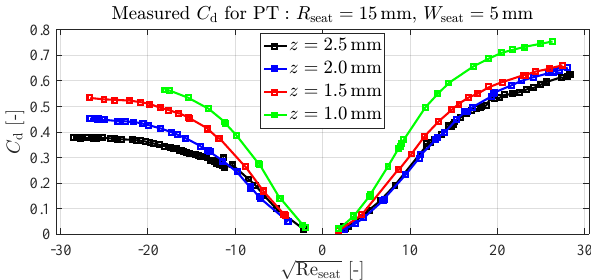
Figure 4: Calculated discharge coefficient as a func- tion of the square-root of the Reynolds num- ber for different seat diameters and stroke lengths. The grey lines indicate the corre- sponding flow rates and the triangles indicate a pressure drop of 1 bar.